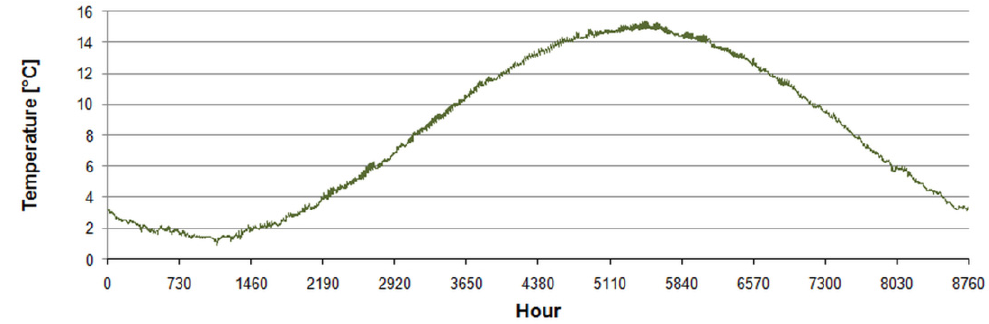
Figure 11. Outlet air temperature (T sup ) from EAHE. Hourly differences between calculated outlet values were also negligible. In relation to method (1), they were from − 0.03 ◦ C to 0.03 ◦ C, from − 0.02 ◦ C to 0.34 ◦ C, from − 0.72 ◦ C to 1.04 ◦ C, and from − 0.72 ◦ C to 0.73 ◦ C, respectively. Therefore, strong correlations between them were obtained (Figures 12 and 13).